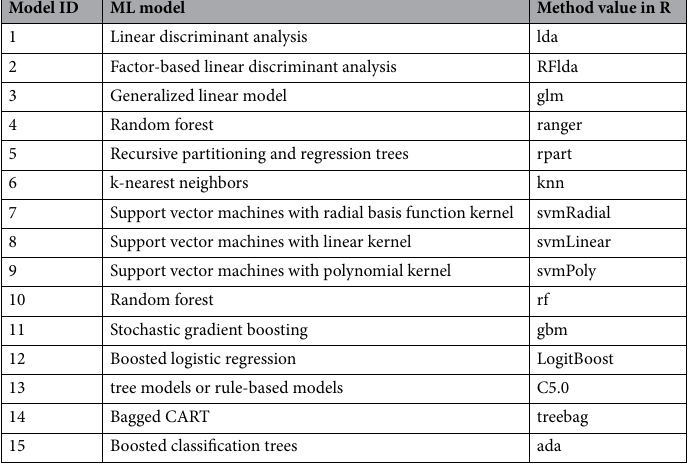
Table 1. The 15 ML models from the R package caret .